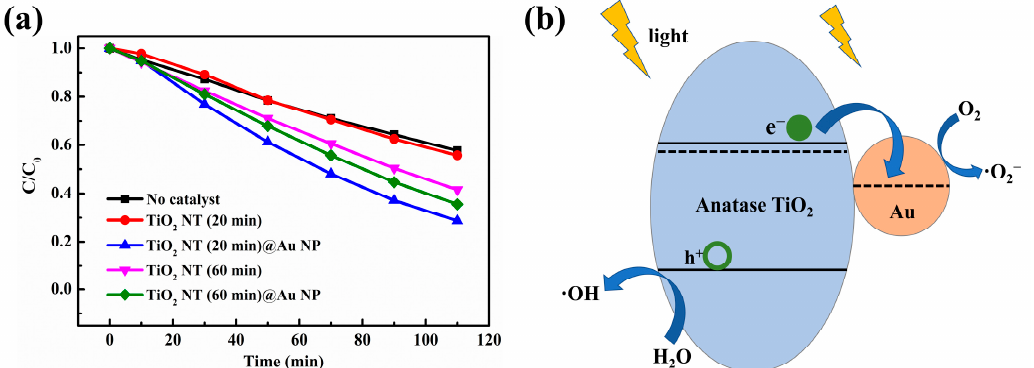
Figure 4. ( a ) TiO 2 NT and TiO 2 NT@Au NP composites with different NT growth times (20 min and 60 min), are used as catalysts for photocatalytic degradation of MB. ( b ) Schematic diagram of photocatalytic degradation of MB by TiO 2 NT (20 min)@Au NP composite.